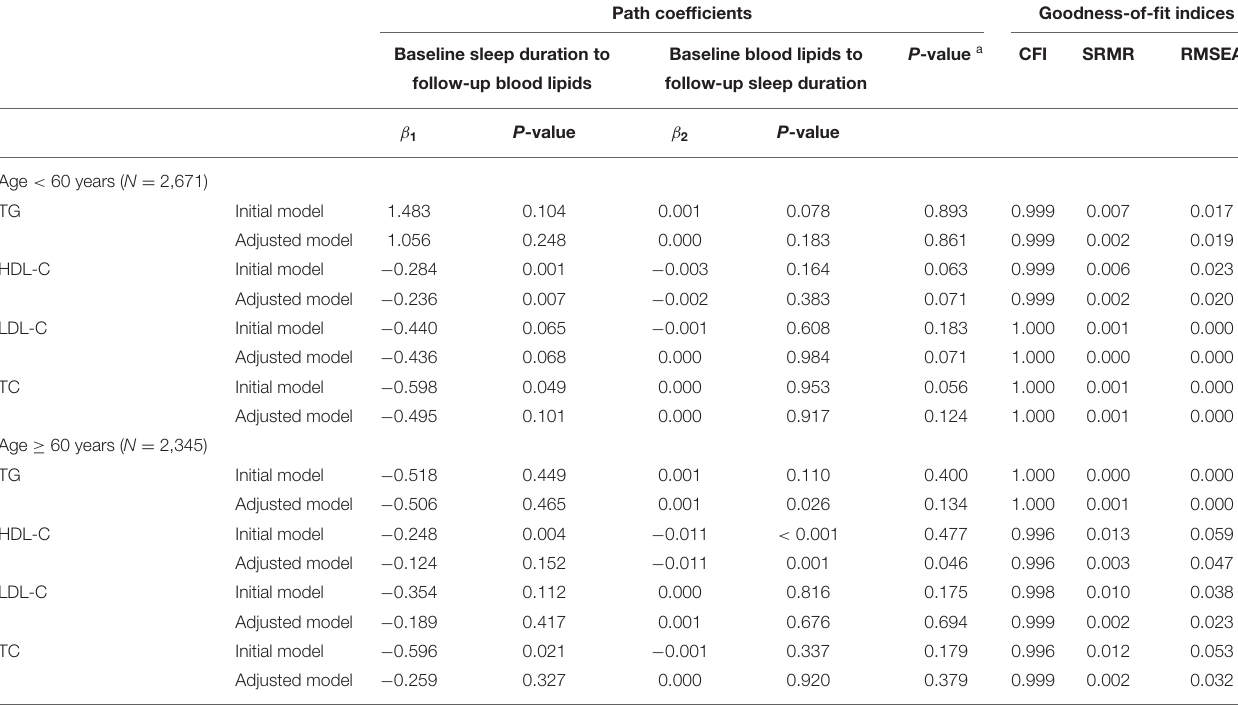
TABLE 3 | Cross-lagged path analysis of TG, HDL-C, LDL-C, TC and sleep duration by